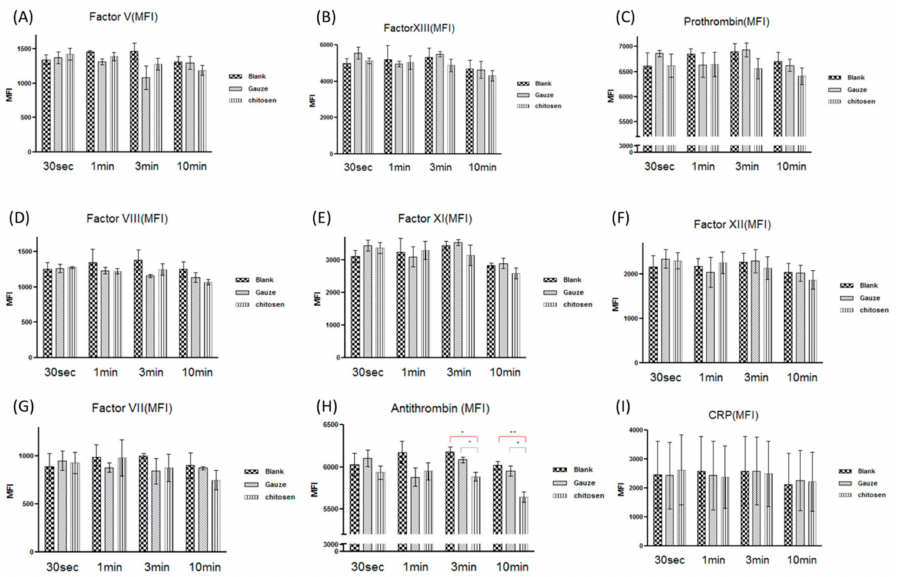
Figure 9. Changes in blood coagulation factor activity in response to gauze and chitosan fiber dressings. ( A ) V, ( B ) XIII, ( C ) prothrombin, ( D ) VIII, ( E ) XI, ( F ) XII, ( G ) VII, ( H ) antithrombin, and ( I ) C-reactive protein (CRP),* p < 0.05, ** p <